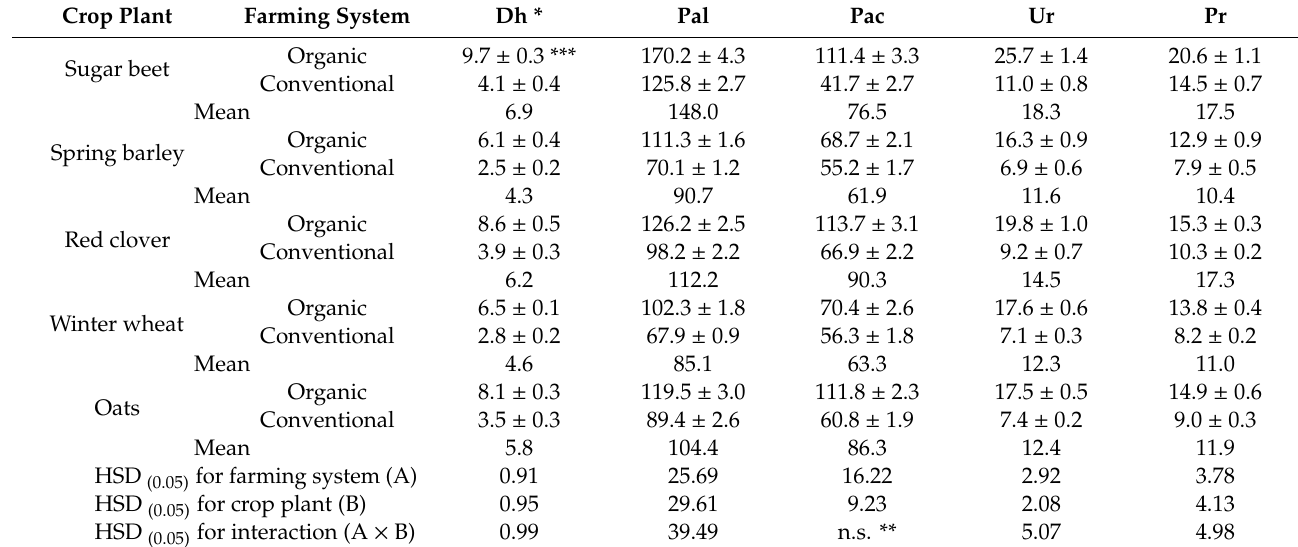
Table 6. Soil enzymatic activity (0–20 cm profile)—mean for 2017–2019. Crop